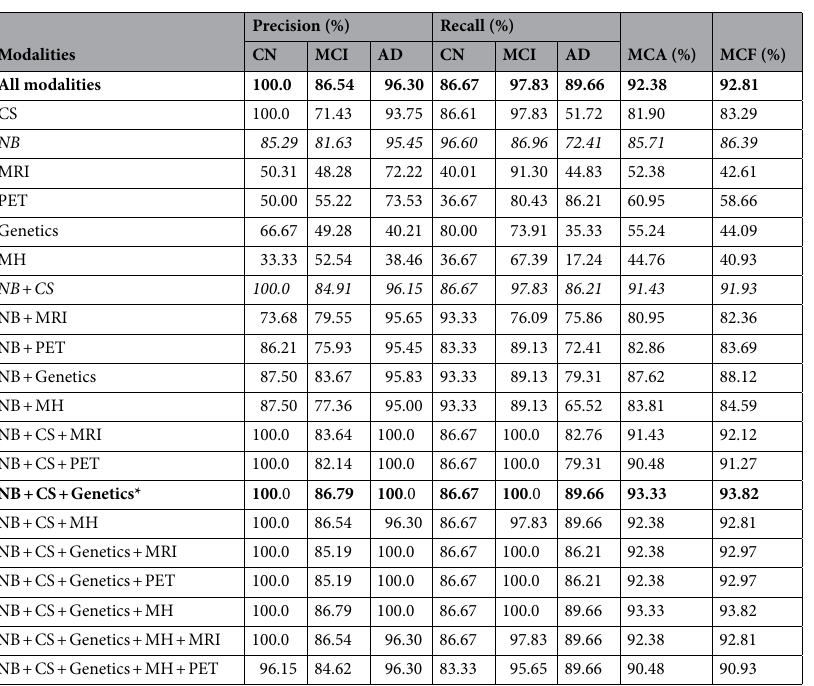
Table 3. Random Forest performance testing for detecting AD patients ( MS 2 test dataset ;10% of the original data). MCA: multiclass classification accuracy, MCF: multiclass F1 score; Asterisk ( *): is the subset of features with the best predictive performance; italic text is the best of single and pairs of